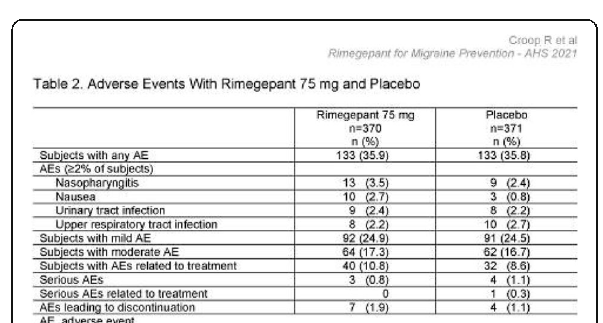
Table 2 (abstract AL054). See text for